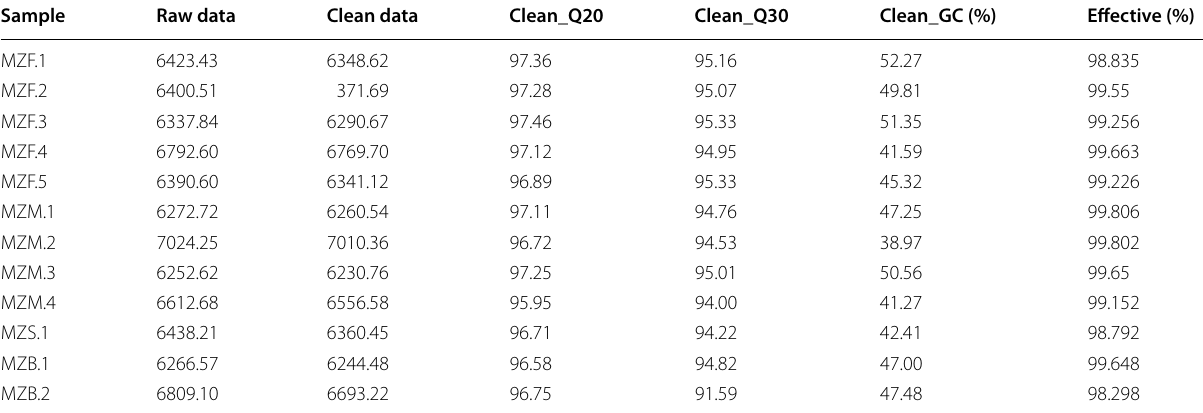
Table 3 The statistical information of sample data